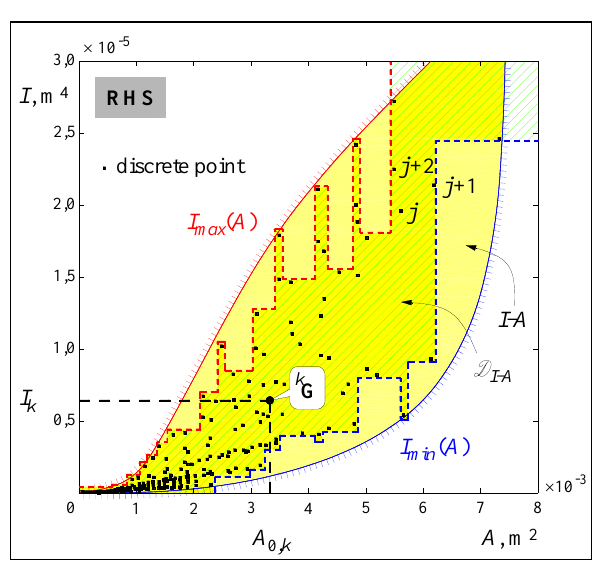
Fig. 5. Admissible fields of the discrete characteristics of IPE and HE profiles A-W pl,y